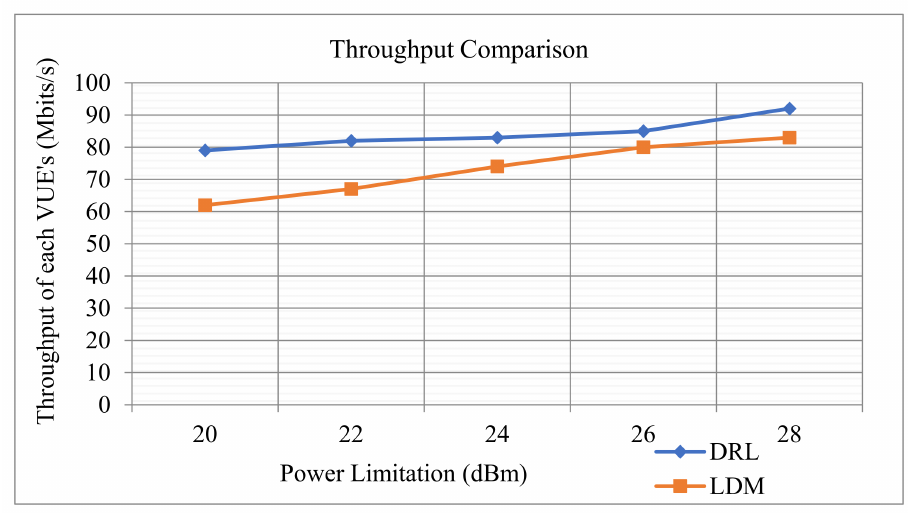
Figure 18. Throughput comparison of Vehicle Users